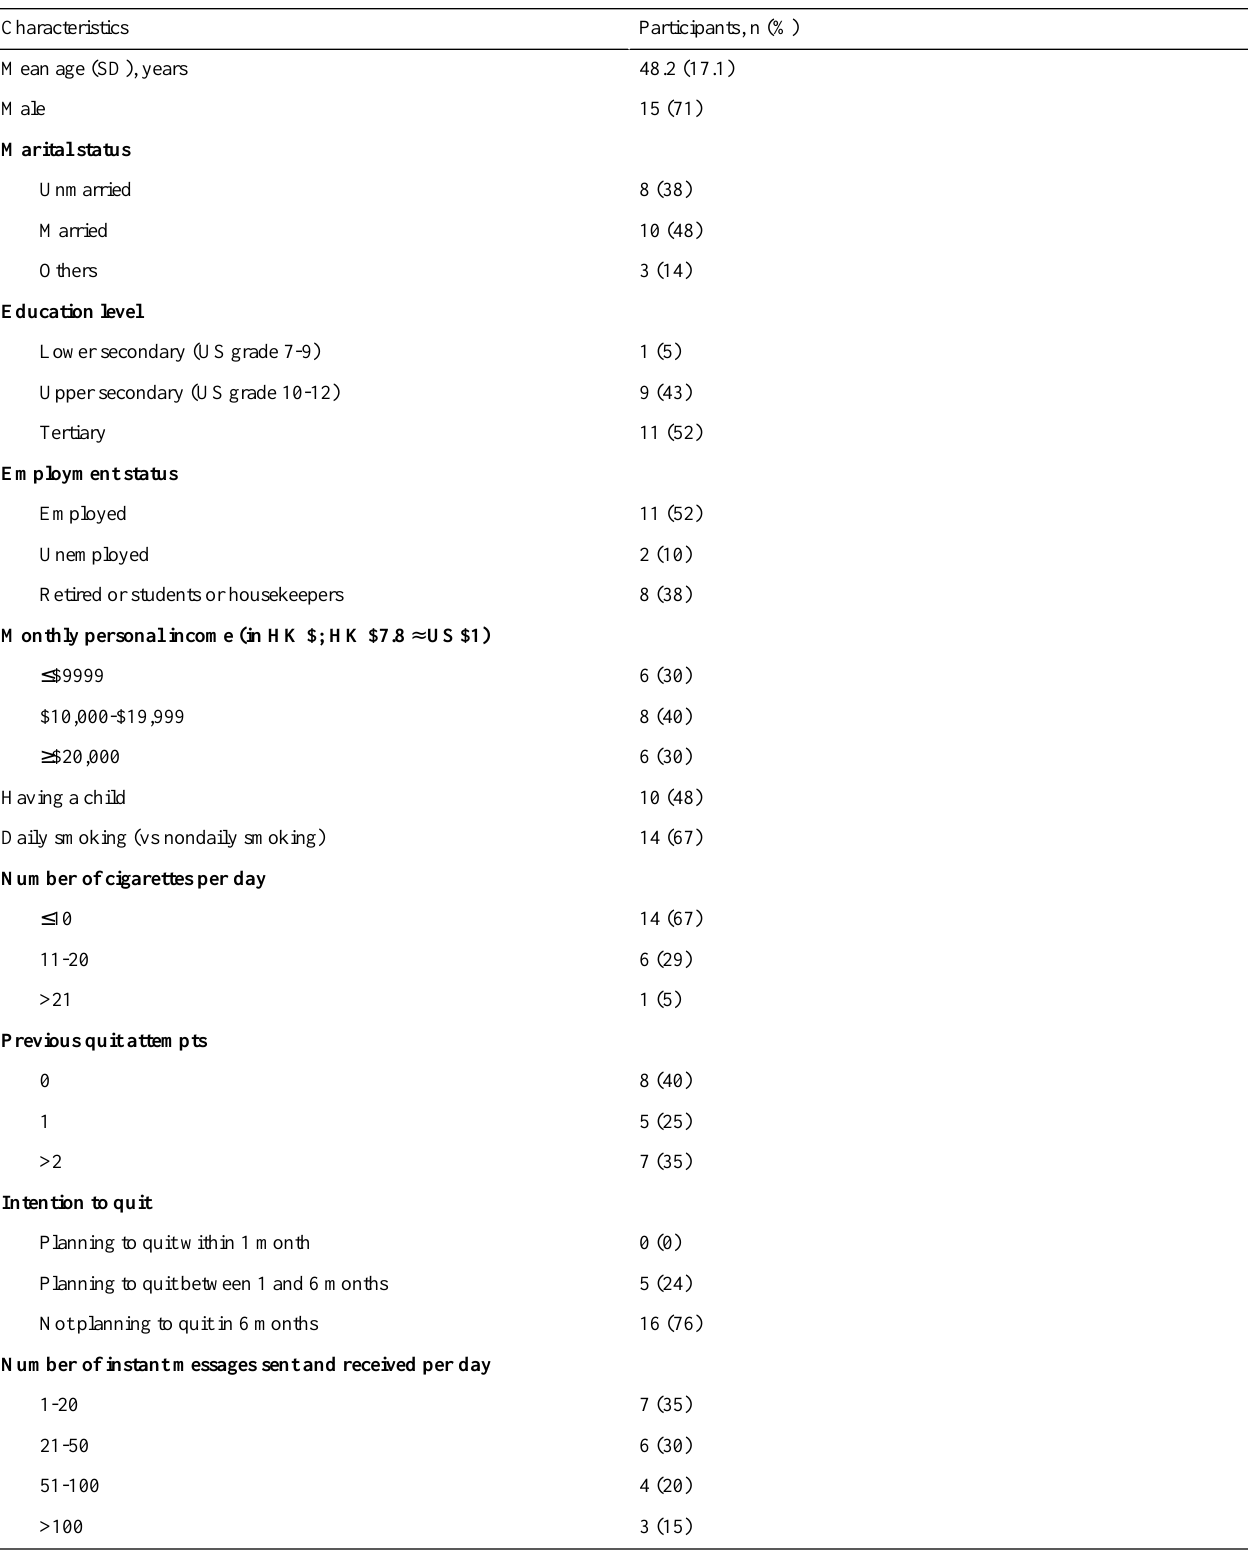
Table 1. Sample characteristics (N=21).